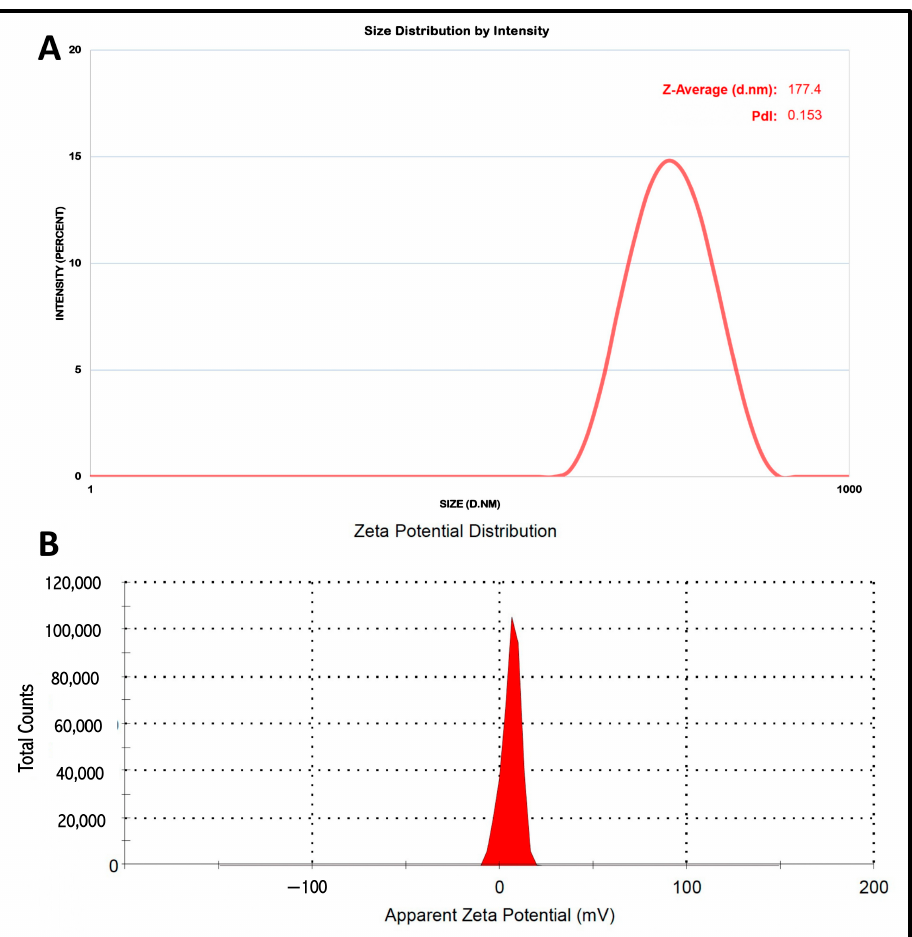
Figure 2. NLC system characterization. ( A ) Particle size: 177.4 nm; ( B ) zeta potential: 5.95 mV.